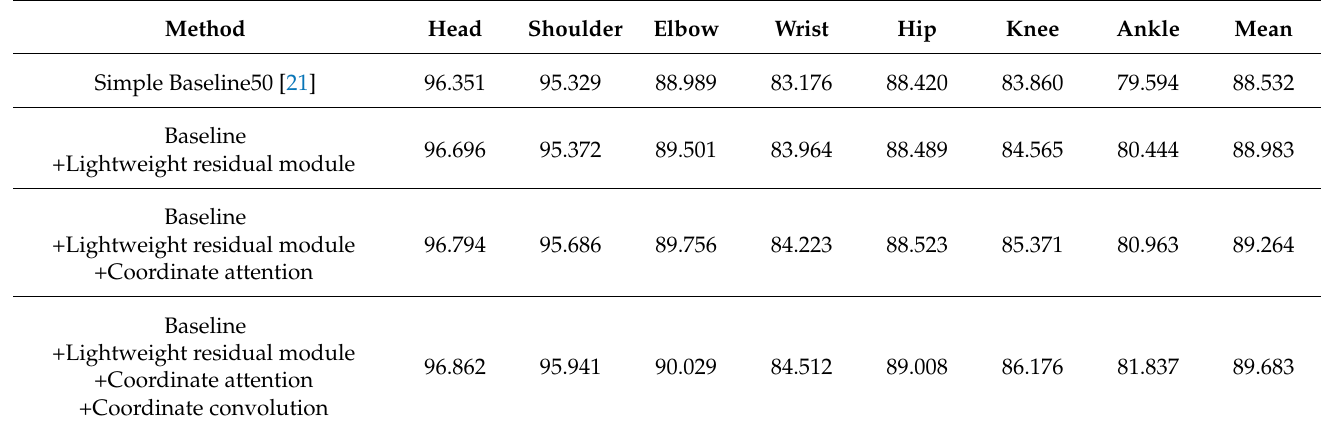
Table 1. Ablation experiment of the models on the MPII dataset